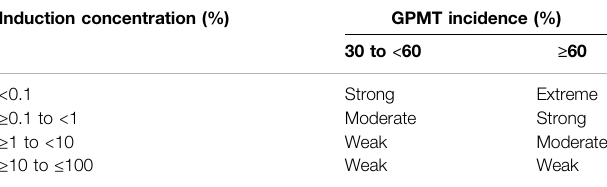
TABLE 4 | The skin sensitization potential based on